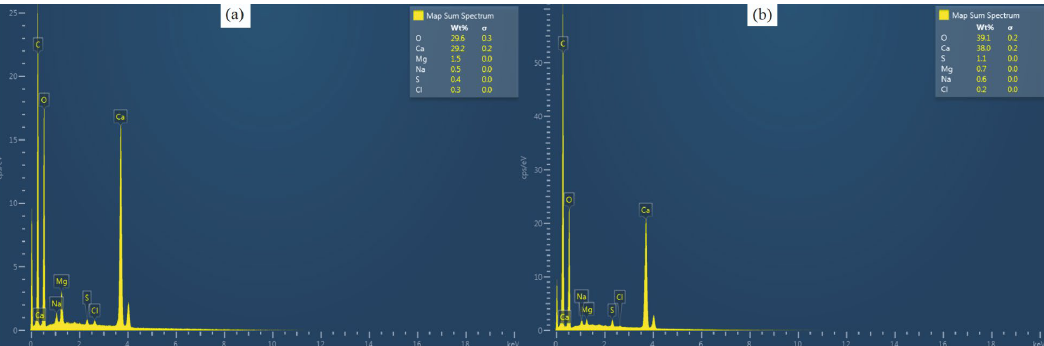
Figure 2. EDS spectra of A. lixula ( a ) test and ( b ) spine.